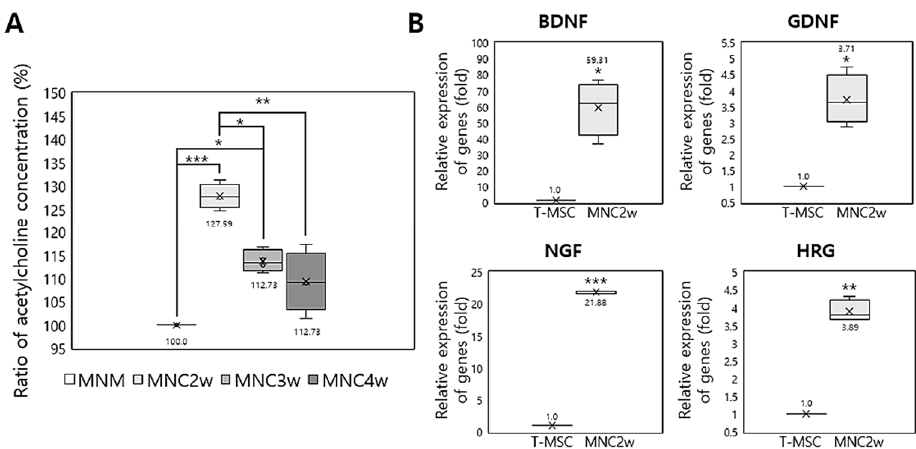
Figure 4. Changes in the secretion of functional MN-related factors after the differentiation of T-MSCs into T-MSC-MNCs. ( A ) Relative acetylcholine secretion during the differentiation into MNCs ( n = 3). ( B ) Relative expression of neurotrophic factors by T-MSCs-MNCs assessed by RT–qPCR ( n = 3). GAPDH served as a loading control. Data are expressed as the mean ± SEM. Triplicate independent mRNA samples were used in the RT–qPCR experiment. MNC1w = 1 week of differentiation; MNC2w = 2 weeks differentiation; MNC3w = 3 weeks differentiation; and MNC4w = 4 weeks differentiation. * p < 0.05; ** p < 0.01; *** p < 0.001.